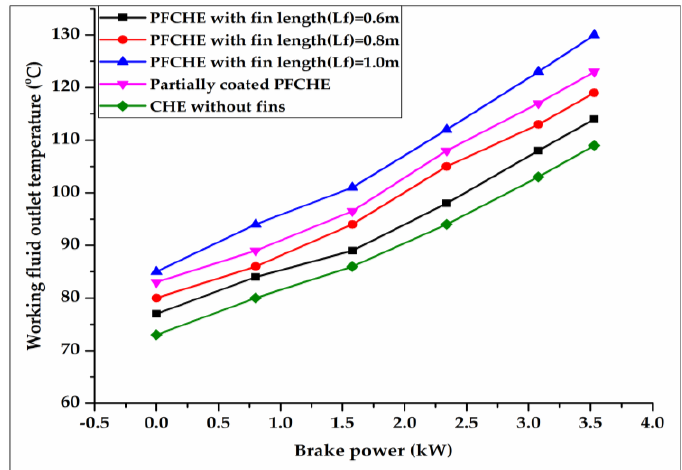
Figure 5. Variation of working fluid outlet temperature with fin geometry.